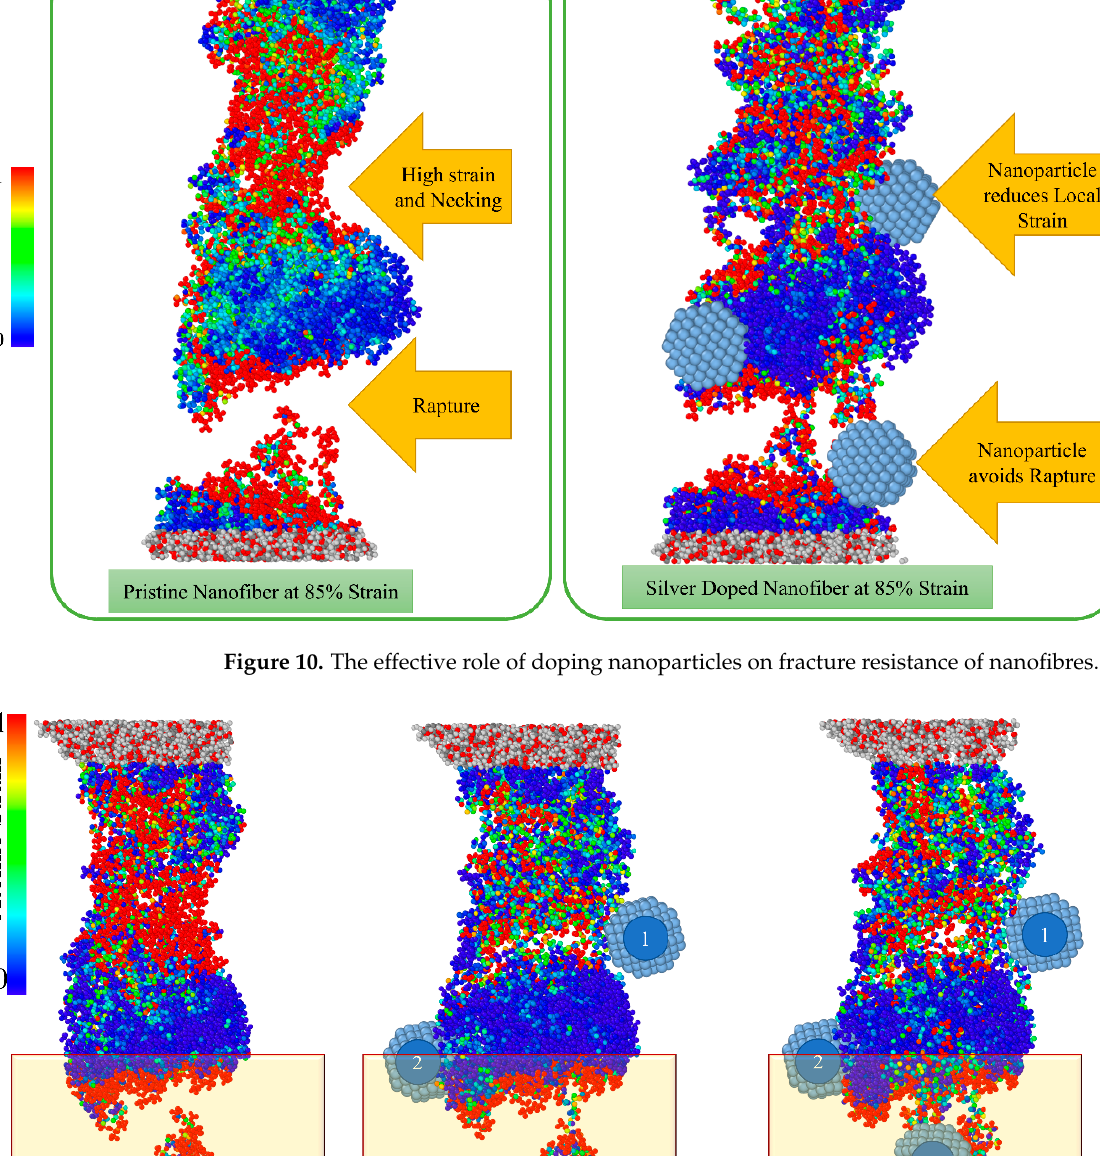
Figure 9. The effect of doping nanoparticles on the distribution of atomic strain in the elastic regime.